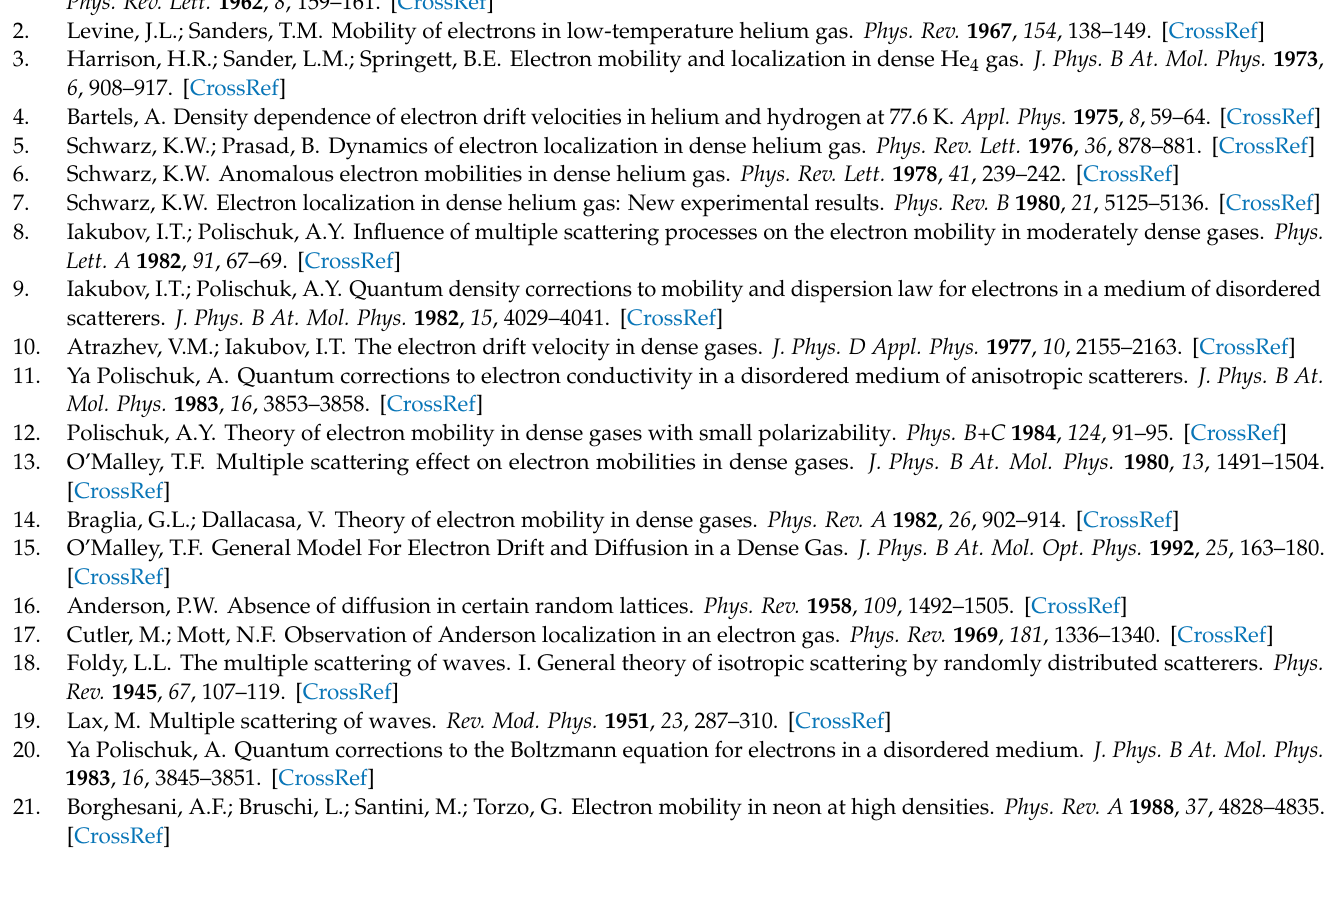
Figure A3. f free vs. E / N at N = 50 T (K) = 300,200, 150, 100, 50, 26.1.